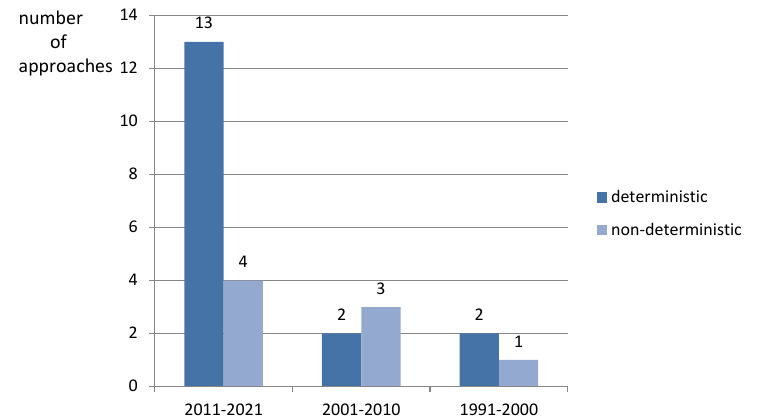
Figure 11. A comparison of analyzed approaches: method